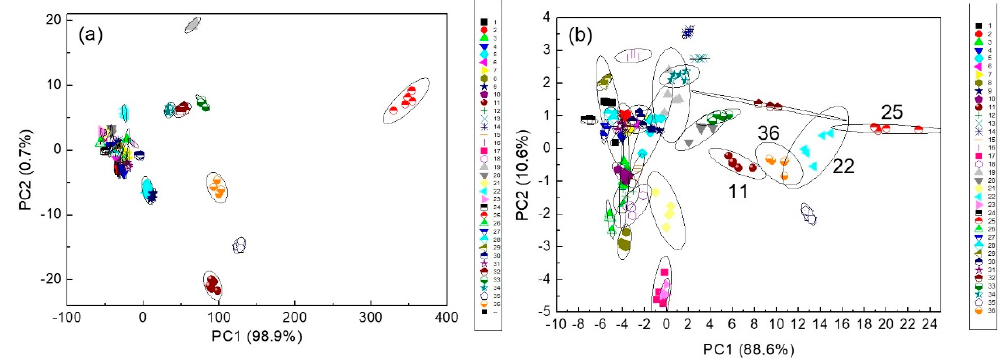
Figure 7. The scores plots of the emission spectra of 36 honey samples with added: ( a ) Ru(bpy) 3 2 + , ( b ) 8-Ox-Zn.